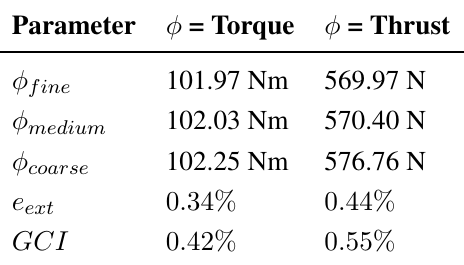
Table 3. Results of the grid convergence